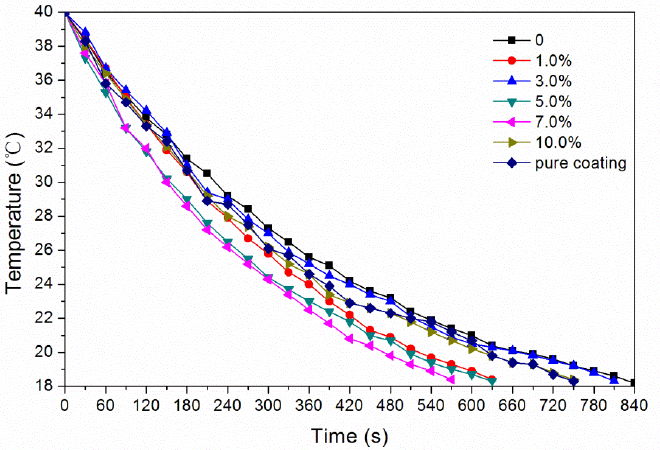
Figure 5. Effect of glass fiber powder concentration on temperature change of naturally cooled waterborne coatings with thermochromic ink.